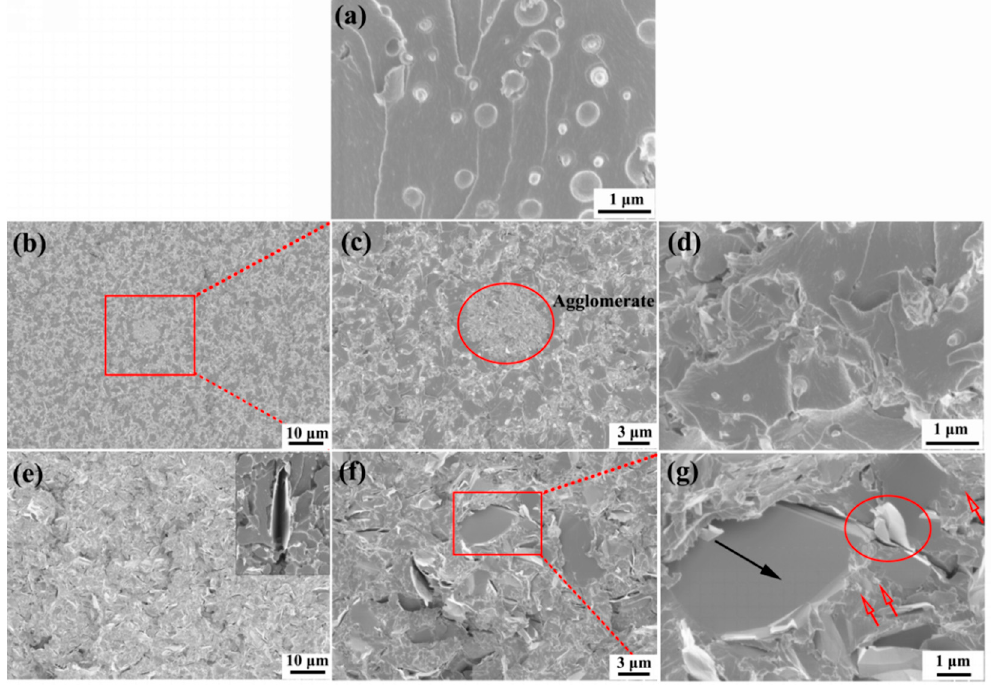
Figure 11. SEM images of CT fracture surfaces of GnPs/PES/epoxy composite: ( a ) 0 wt % GnPs; ( b – d ) 3 wt % GnP-C750; ( e – g ) 3 wt % GnP-5.